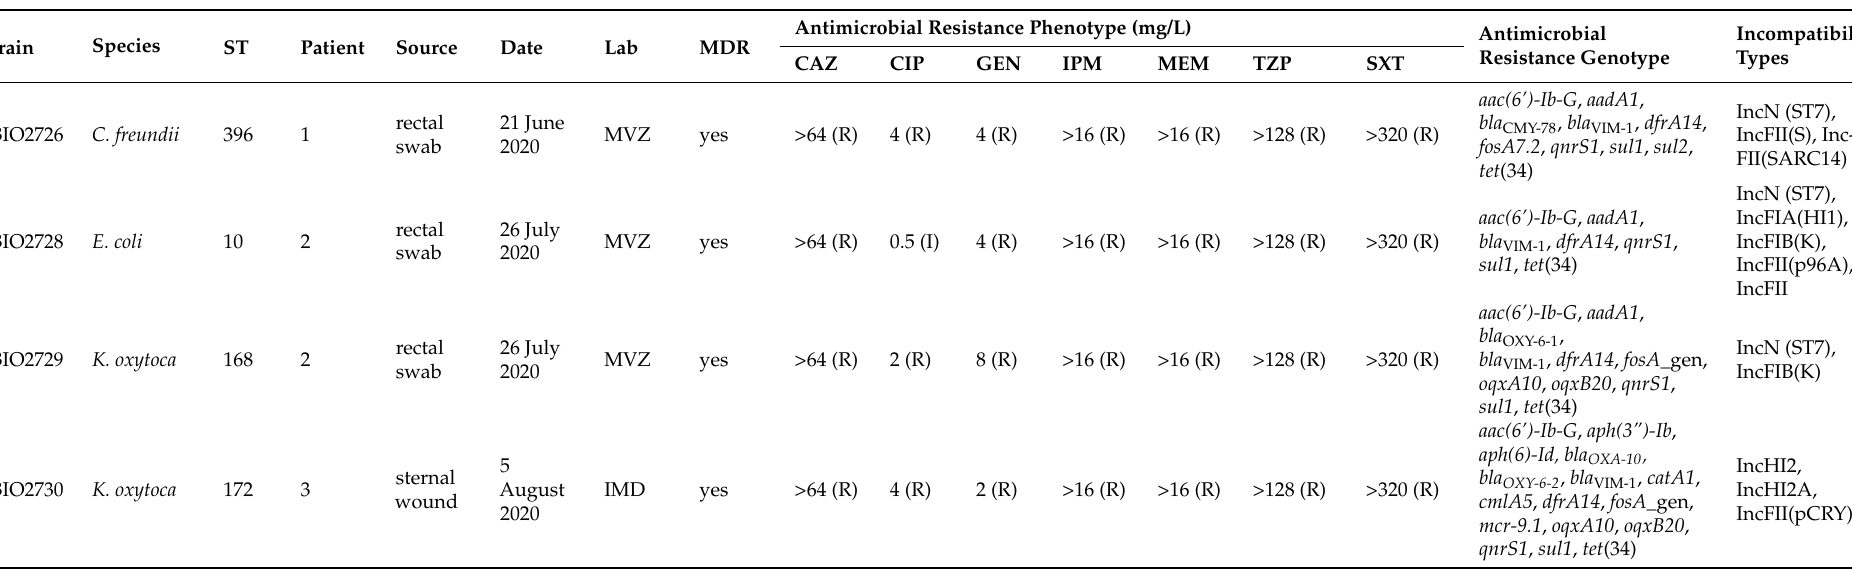
Table 1. Overview of all four investigated isolates and associated geno- and phenotypic data. Only the most important resistance and plasmid incompatibility genes are displayed. Comprehensive results can be found in Table S1. Minimal inhibitory concentrations against the tested antibiotics are displayed in